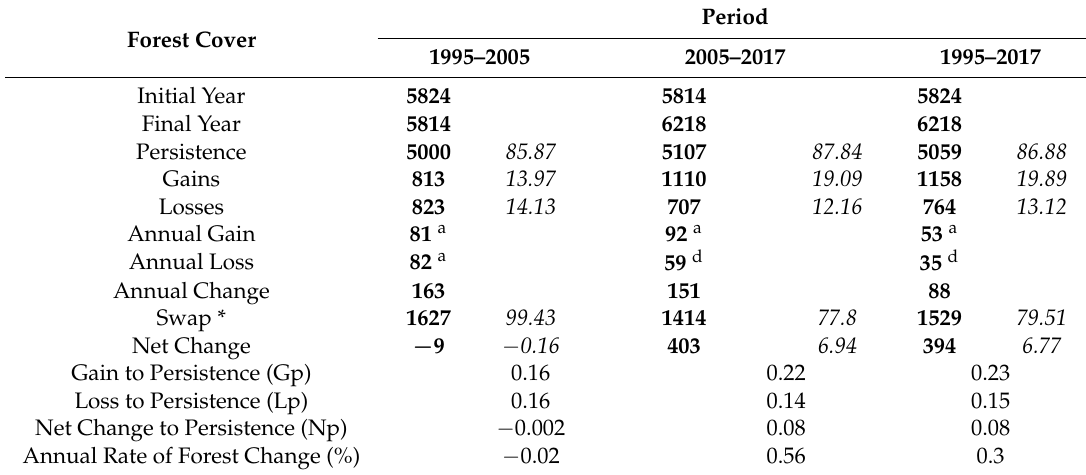
Table 7. Summary of forest cover change between 1995 and 2017.